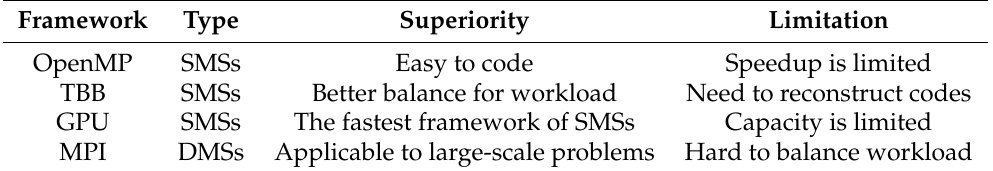
Table 2. The superiority and limitation of different parallelization